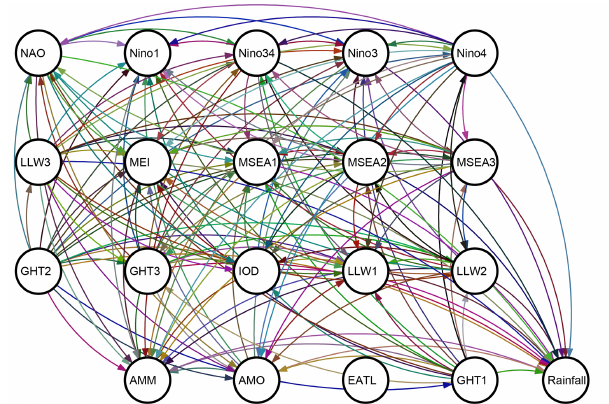
Figure 8. Resulting combined network for coupling inciter EATL 8